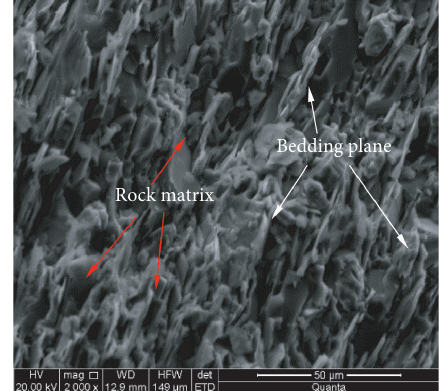
Figure 1: Layered structure observed under